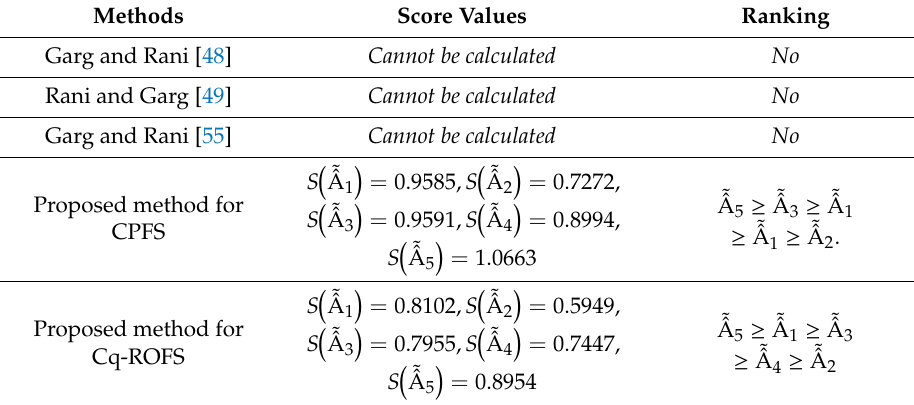
Table 8. Comparison between proposed methods and existing methods.